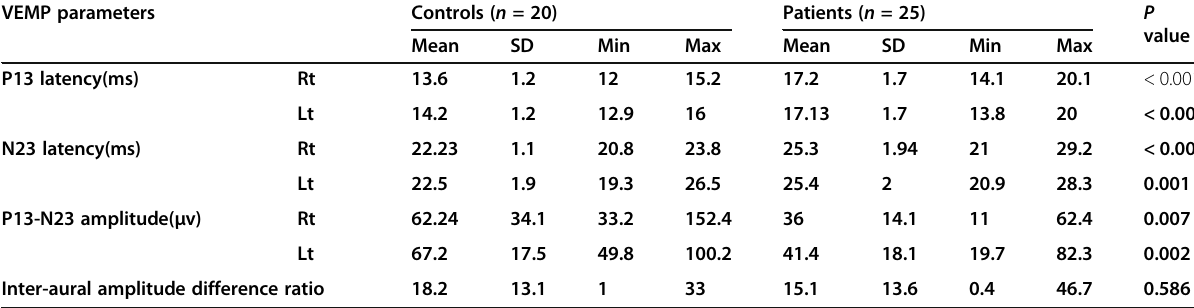
Table 3 Comparison between BD patients and the controls regarding cVEMP results VEMP parameters